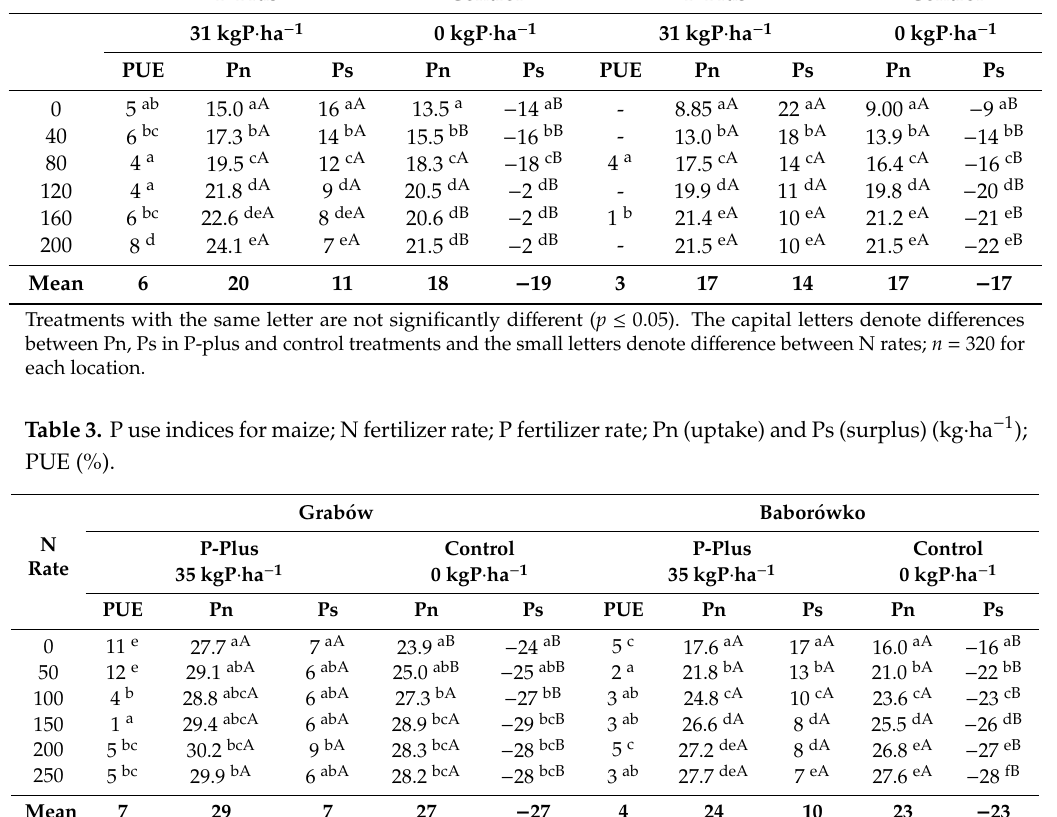
Treatments with the same letter are not significantly di ff erent ( p ≤ 0.05). The capital letters denote di ff erences between the mean of Pn, Ps in P-plus and control treatments and the small letters denote di ff erence between N rates; n = 280 for Grab ó w; n = 240 for Babor ó wko. Table 2. P use indices for winter wheat; N fertilizer rate; P fertilizer rate; Pn (uptake) and Ps (surplus) (kg · ha − 1 ); PUE (%). Grab ó w N Rate